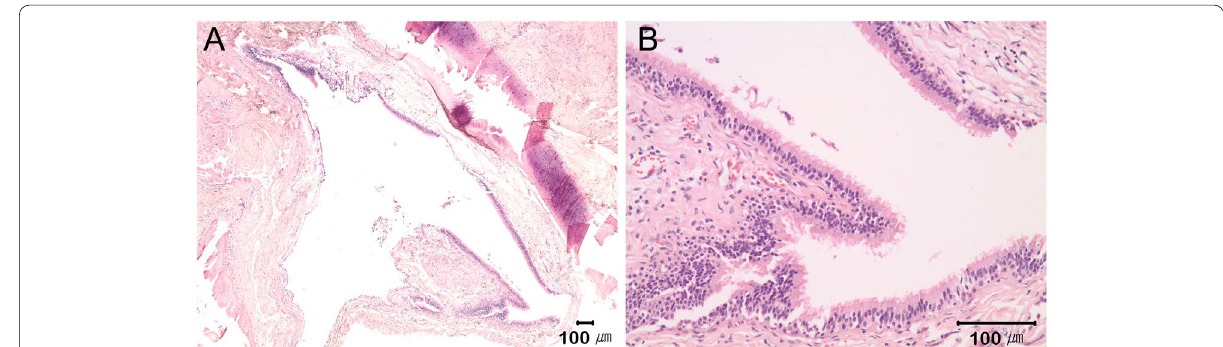
Fig. 3 Hematoxylin and eosin staining revealed pathologic features of the cyst. The cyst wall was lined by ciliated pseudostratified columnar